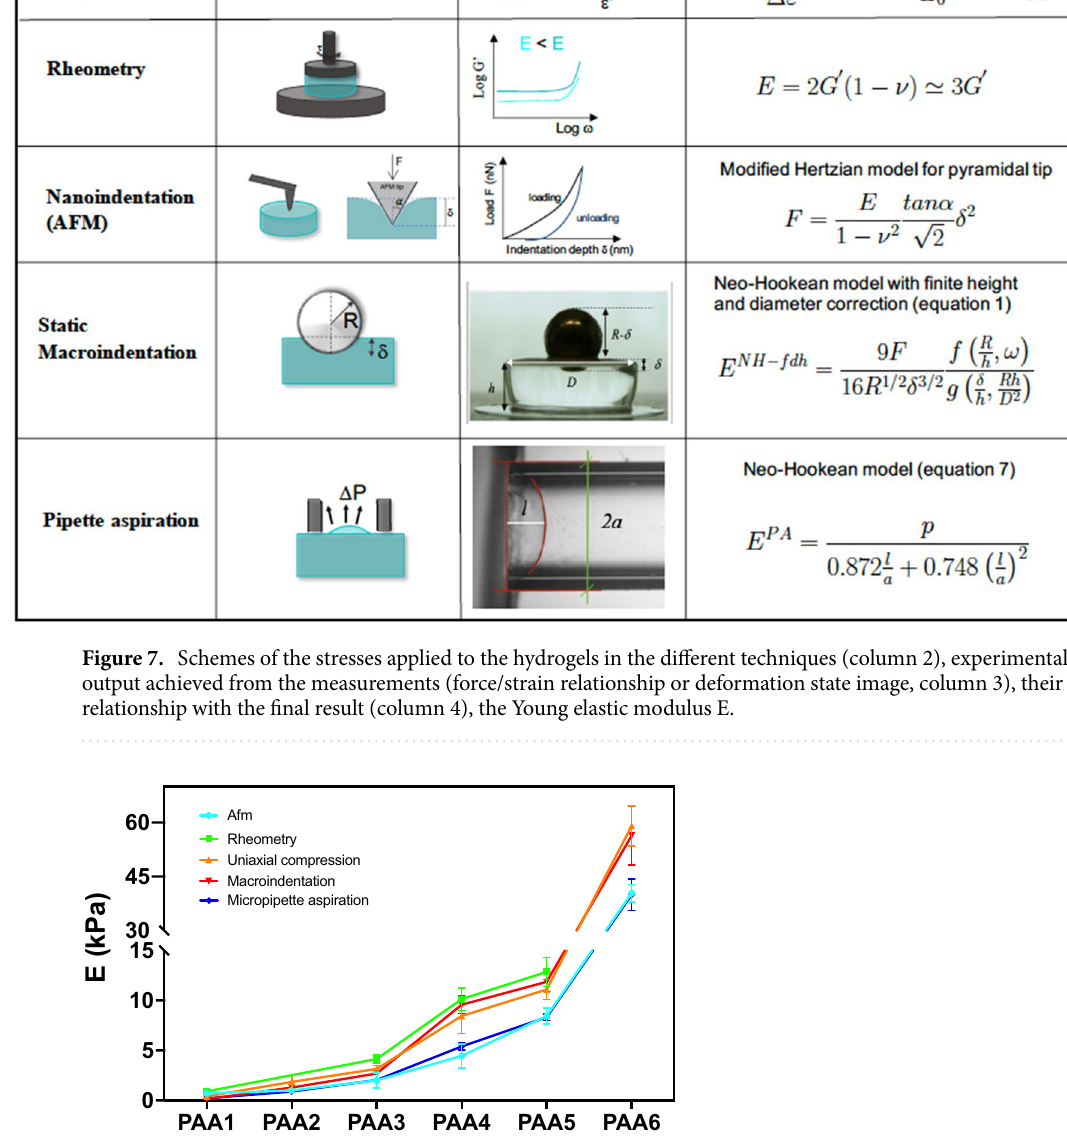
Figure 8. Elastic modulus of PAA hydrogels measured with micro indentation AFM (*sharp tip, from ref 3 ), static macro sphere indentation, rheometry, pipette aspiration and uniaxial compression tests. Numerical data are reported in Table 4. In Fig. S8 errors data are